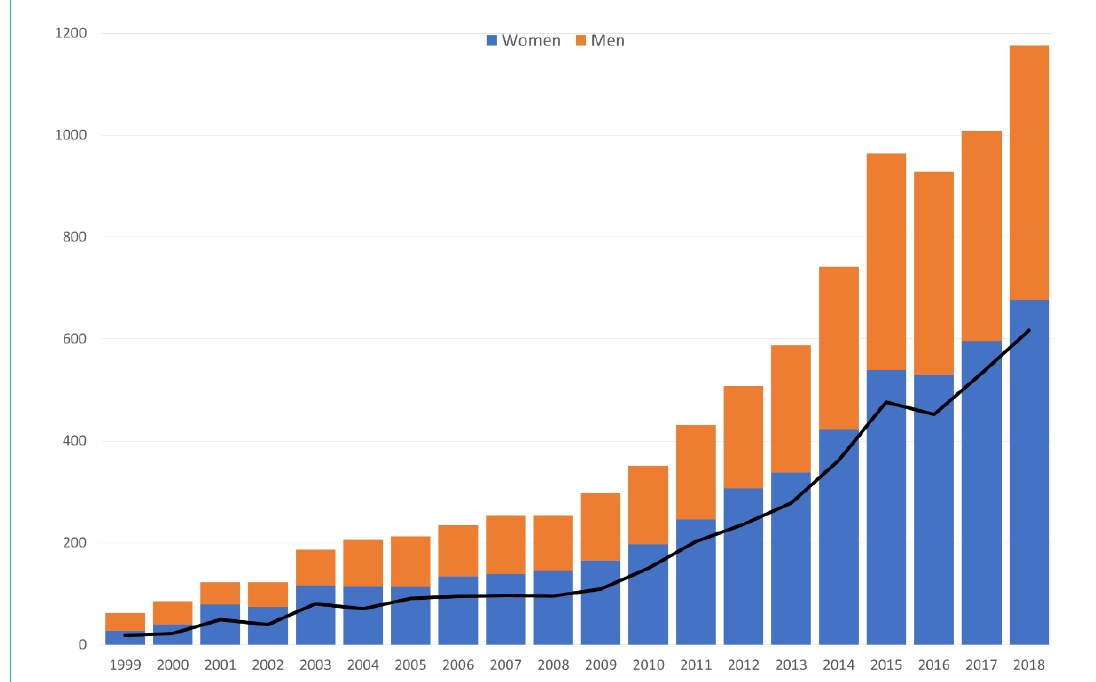
Figure 1: Assisted suicide in Switzerland 1999–2018: sex and advanced age (≥80 years at time of death) distribution. Sex: There was a sta ble predominance of women over the four defined time intervals: 1999–2003: 58.1%; 2004–2008: 55.7%; 2009–2013: 57.6%; 2014–2018: 57.3%. Advanced age, i.e. persons ≥80 years at time of assisted suicide (black line): 1999–2003: 36.4% (♀ 39.6%; ♂ 32.0%); 2 004–2008: 39.1% (♀ 40.6%; ♂ 37.1%); 2009–2013: 45.0% (♀ 49.0%; ♂ 39.5%); 2014–2018: 50.6% (♀ 54.0%; ♂